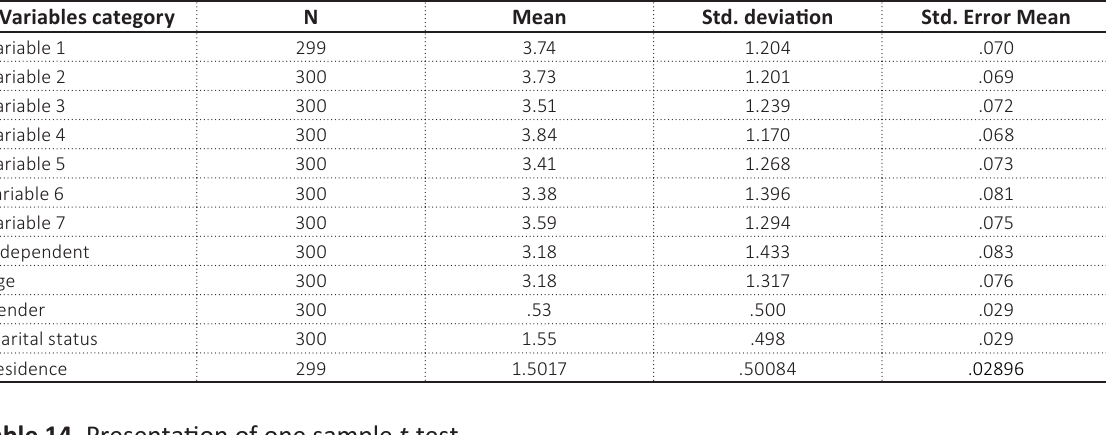
Table 13. Representation of one-sample statistics 300 respondents